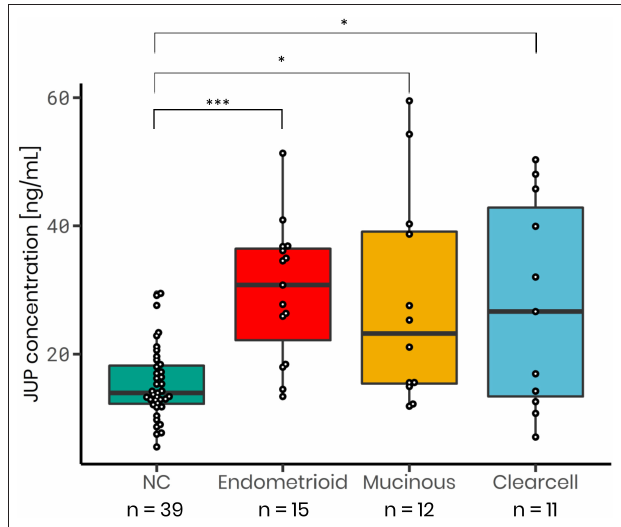
FIGURE 4 | JUP serum concentration is increased in non-serous stage I ovarian cancer subtypes: Endometrioid (median = 30.80ng/mL; 1.93-fold increase; p < 0.001; n = 15), mucinous (median = 23.21ng/mL; 1.82-fold increase; p = 0.0229; n = 12) and clear cell carcinoma (median = 26.65ng/mL; 1.79-fold increase; p = 0.0329; n = 11) as in comparison to normal control samples (NC; median = 13.94ng/mL; n = 39). P -values were calculated using a t -test. * p -value < 0.05, *** p -value <